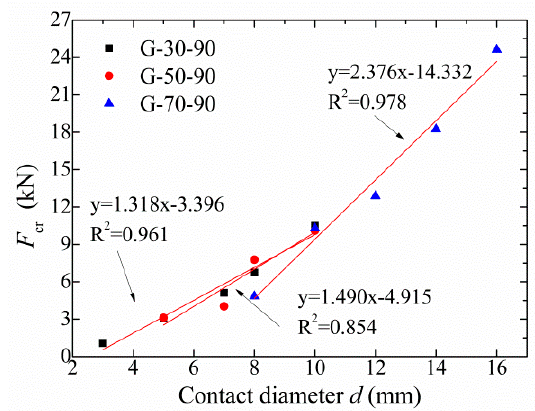
Figure 12. Relationship between critical normal force F cr and contact diameter d .